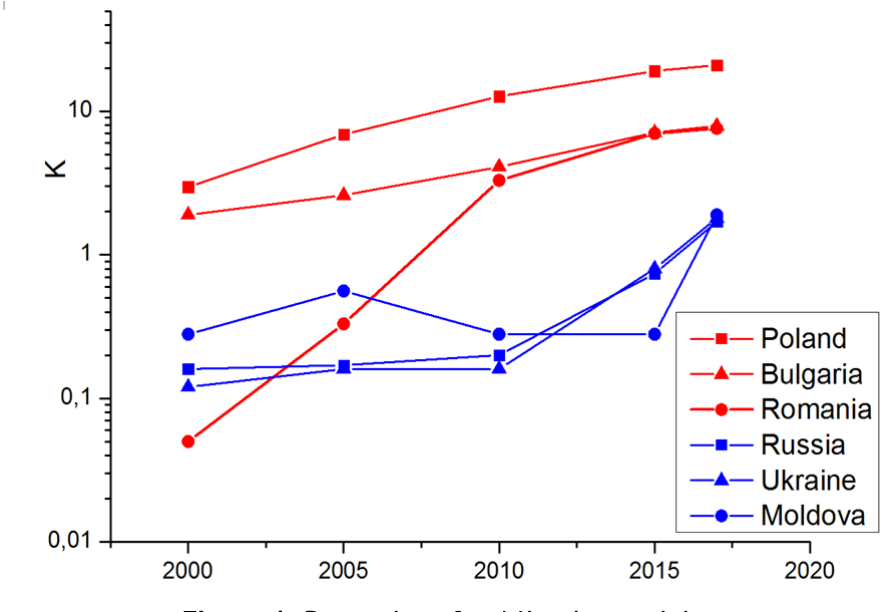
Figure 1. Dynamics of publication